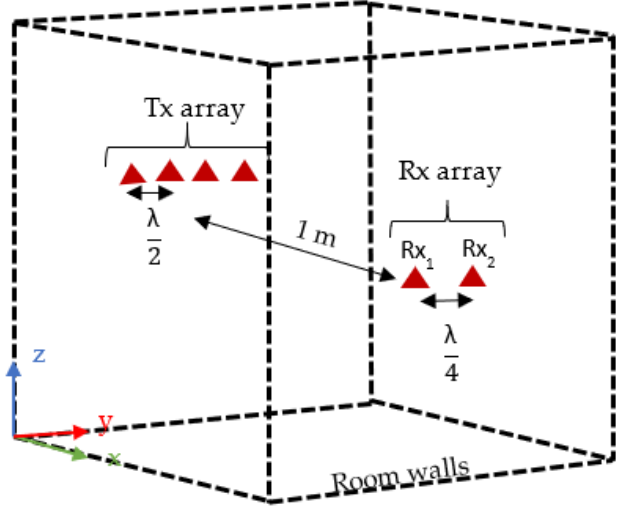
Figure 7. 2 × 1 Rx array configuration for RF energy harvesting MIMO system. Table 2. Average received power in watts.